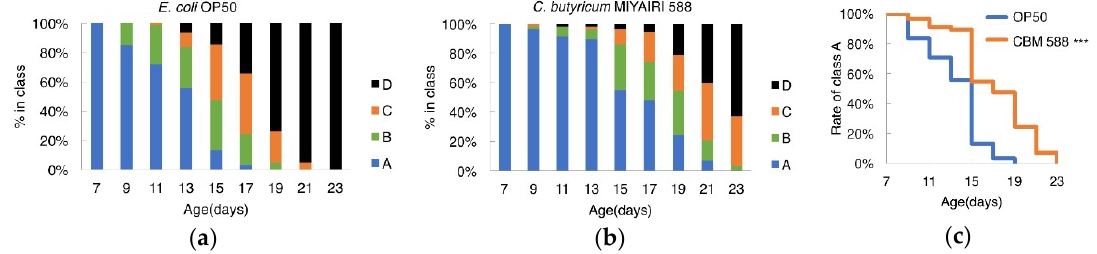
Figure 3. CBM588 improved locomotion during aging in C. elegans . ( a , b ) Locomotory activity of C. elegans fed OP ( a ) or CBM 588 ( b ). Animals were grouped into the following four classes based on their locomotion: class A, robust, coordinated sinusoidal locomotion (blue bars); class B, uncoordinated and/or sluggish movement (green bars); class C, no forward or backward movement, but head movements or shuddering in response to prodding (orange bars); and class D, dead animals (black bars). The frequency of each class at the indicated time point is indicated. n ≥ 57 for each assay. ( c ) The difference in the frequency of “Class A” worms was analyzed using the log-rank test. *** p < 0.001. OP50, n = 61, CBM 588, n = 57.